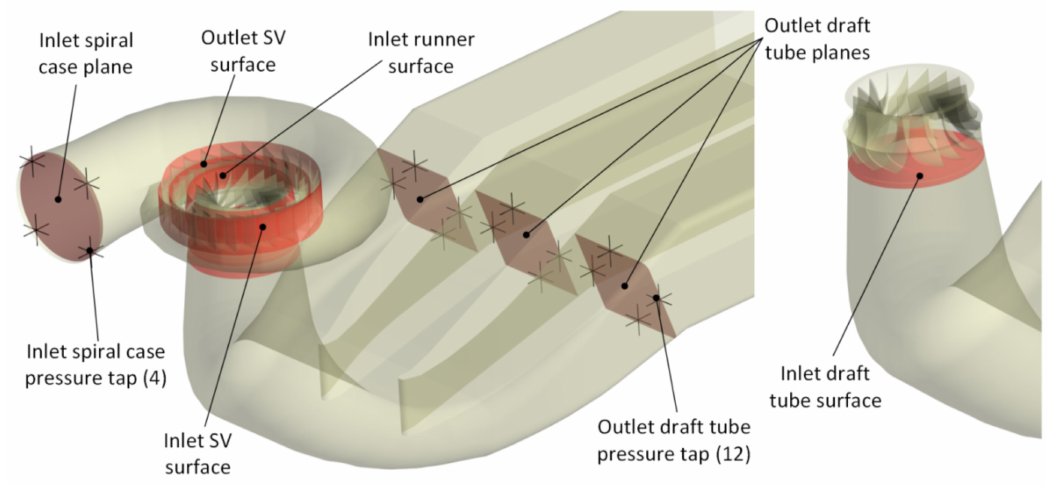
Figure 4. Surfaces and pressure tap locations to evaluate turbine head and components efficiency